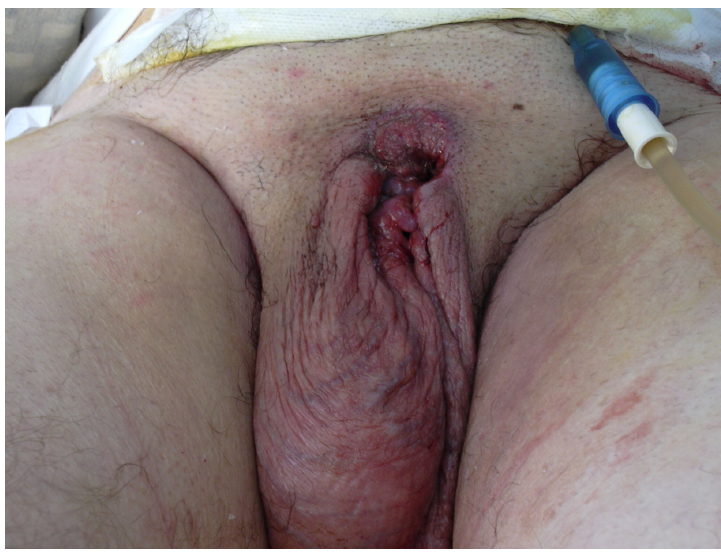
FIGURE 2 . Suprapubic catheter placed due to unsuccessful catheterization of the